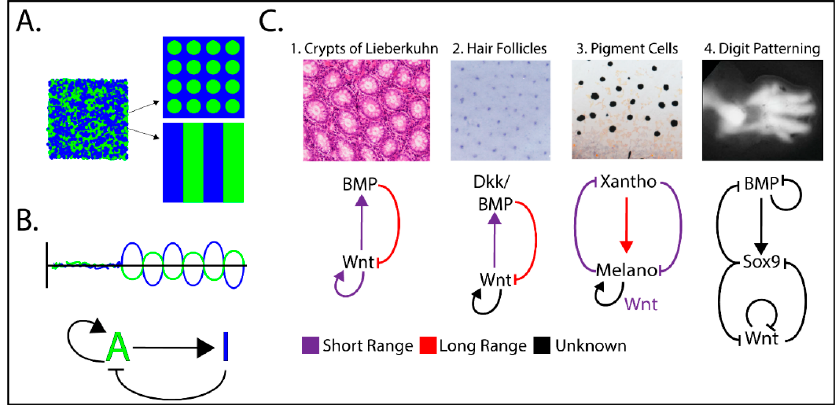
Figure 3. Examples of Wnt/ β -catenin-dependent Reaction-Diffusion (RD) mechanisms implicated in tissue patterning. ( A ) Over time, a short-range activator and a long-range inhibitor interact to form local morphogen concentrations in patterns. ( B ) Basic model for the RD activator/inhibitor pair. ( C ) Examples of Wnt-driven patterning driven by RD mechanisms. Although the morphogen pairs/triplets and their mechanisms of control varies, the basic activator/inhibitor concepts are maintained and predicted by mathematical modeling. Patterning images C1–C4 were adapted from References